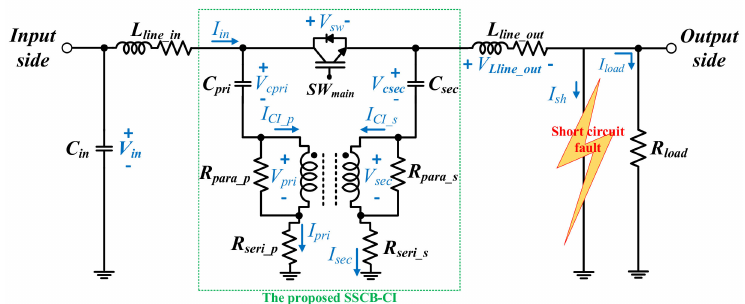
Figure 1. Circuit configuration of the proposed solid-state circuit breakers